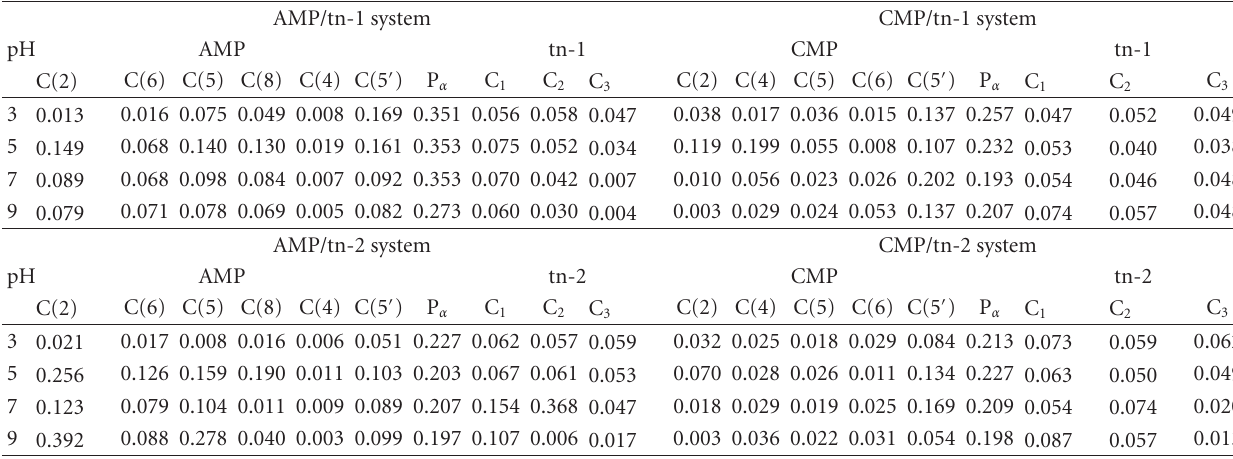
Table 2: Di ff erences between 13 C NMR and 31 P NMR chemical shifts for the ligands in the AMP / tn-1, AMP) / tn-2, CMP/tn-1 and CMP / tn- 2 systems in relation to the free ligands (ppm).